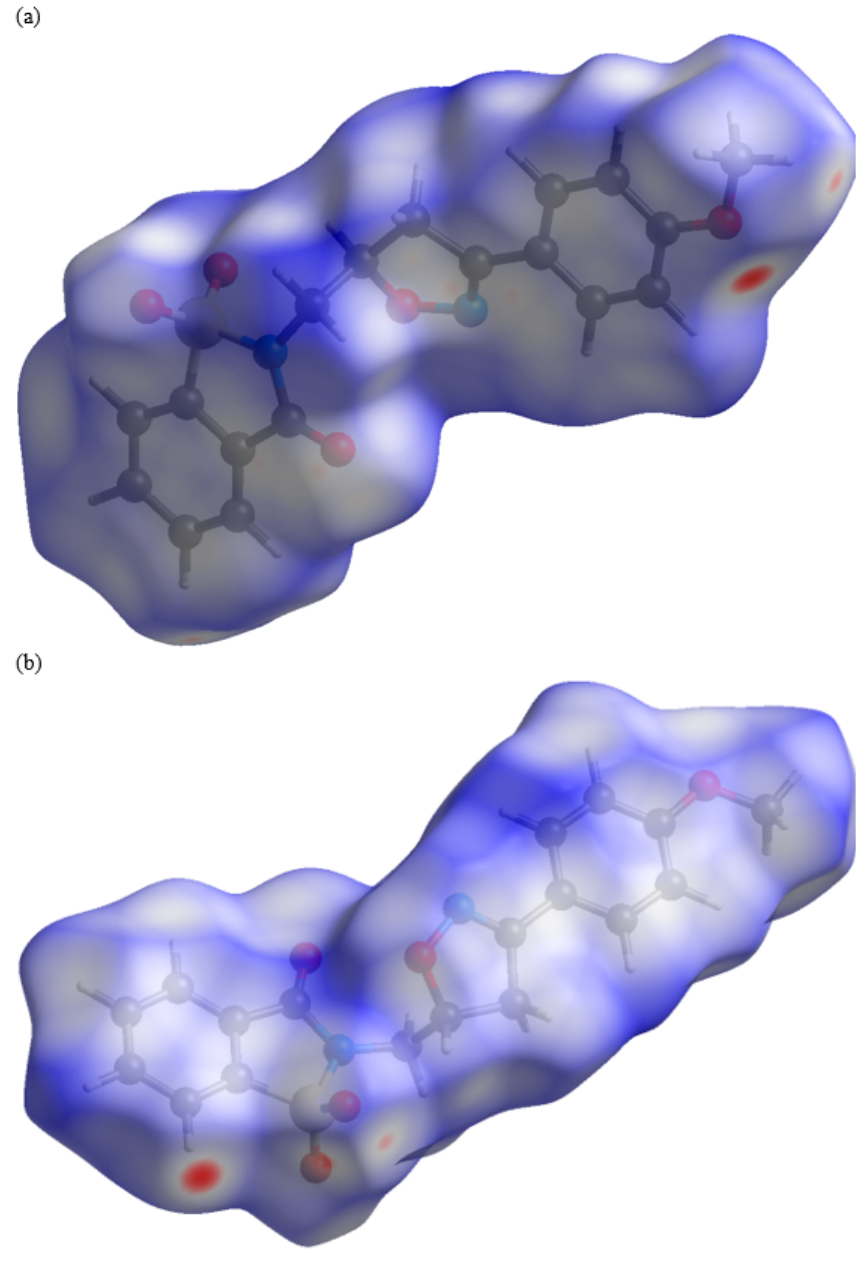
Figure 4. View of the three-dimensional Hirshfeld surface face 1 ( a ) and 2 ( b ) of the title compound, plotted on d norm in the range of − 0.1656 to 1.2318 a.u. The three-dimensional d norm surfaces of the crystal structure illustrate the presence of several bright red spots, which correspond to the hydrogen bonding interactions, as shown in Figure 5.